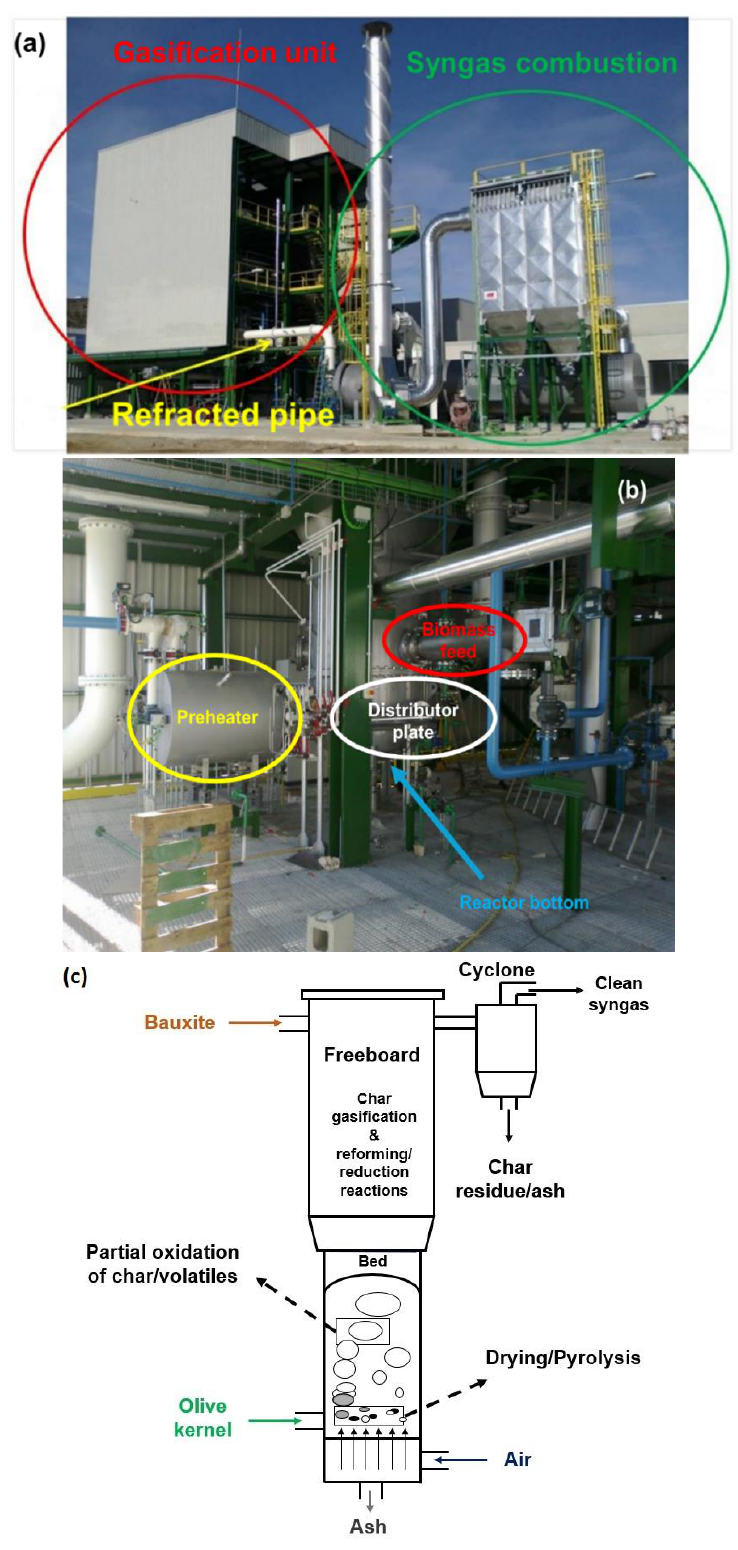
Figure 6. ( a ) General view of the gasification pilot plant, ( b ) the bottom part and ( c ) schematic representation of the BFB gasifier at BIO2C (adapted from [54]). Table 4. Technical characteristics of the gasification plant.